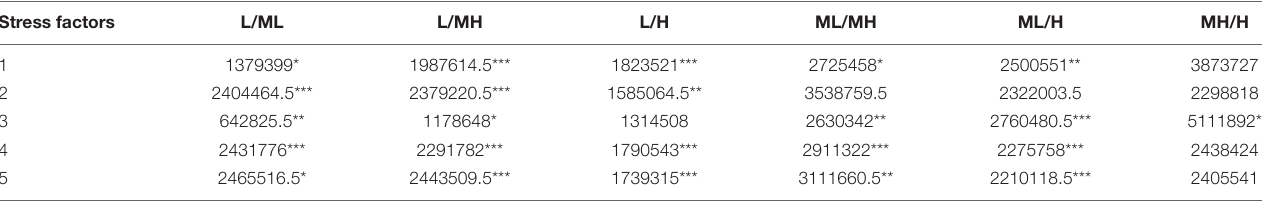
TABLE 5 | U de Mann Whitney values of the post hoc contrasts for Personal fulfillment according to the Levels of